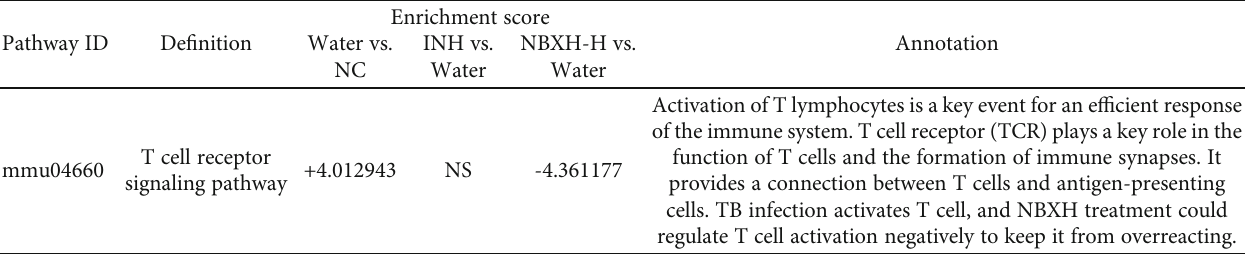
regulate T cell activation negatively to keep it from